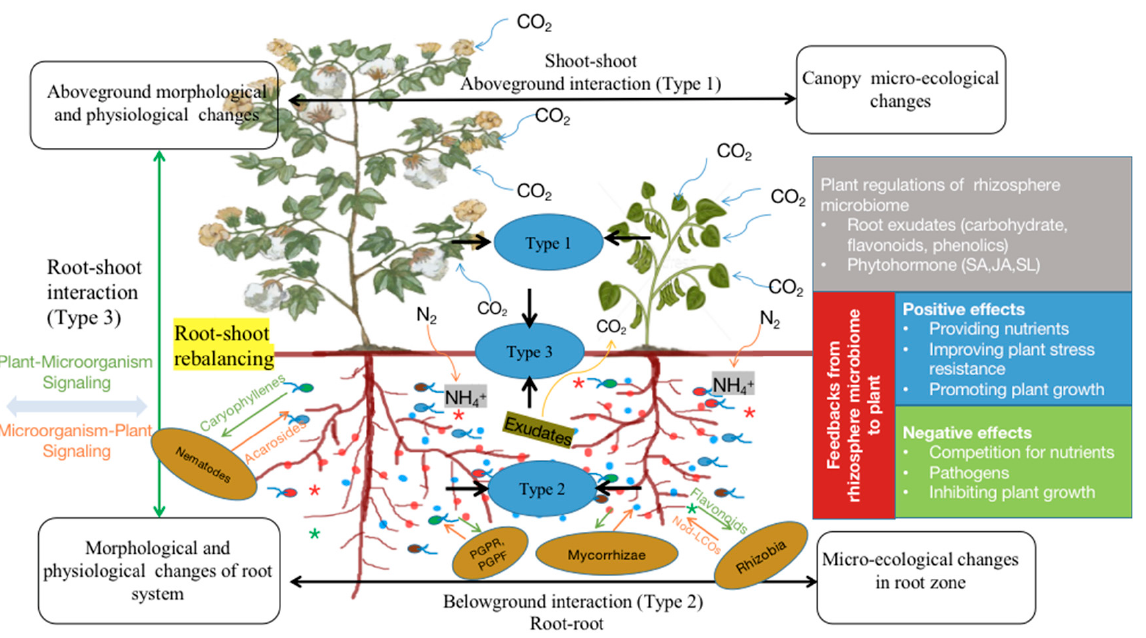
Figure 2. Schematic diagram of rebalancing root–shoot relations in alternate intercropping with cotton and soybean (Refer to Liu et al., 2021 [112] for the text in the box in the